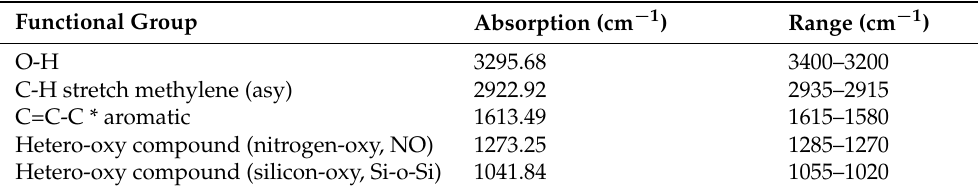
Table 3. FTIR analysis of P. macrocarpa ethanol fruit extract.